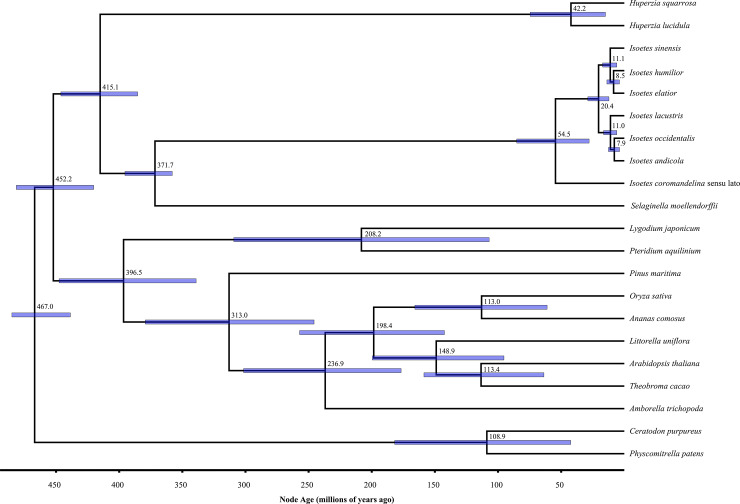
Maximum clade credibility tree for combined nuclear subsamples in BEAST.Node labels represent ages (Ma), blue bars represent 95% mean HPD intervals.